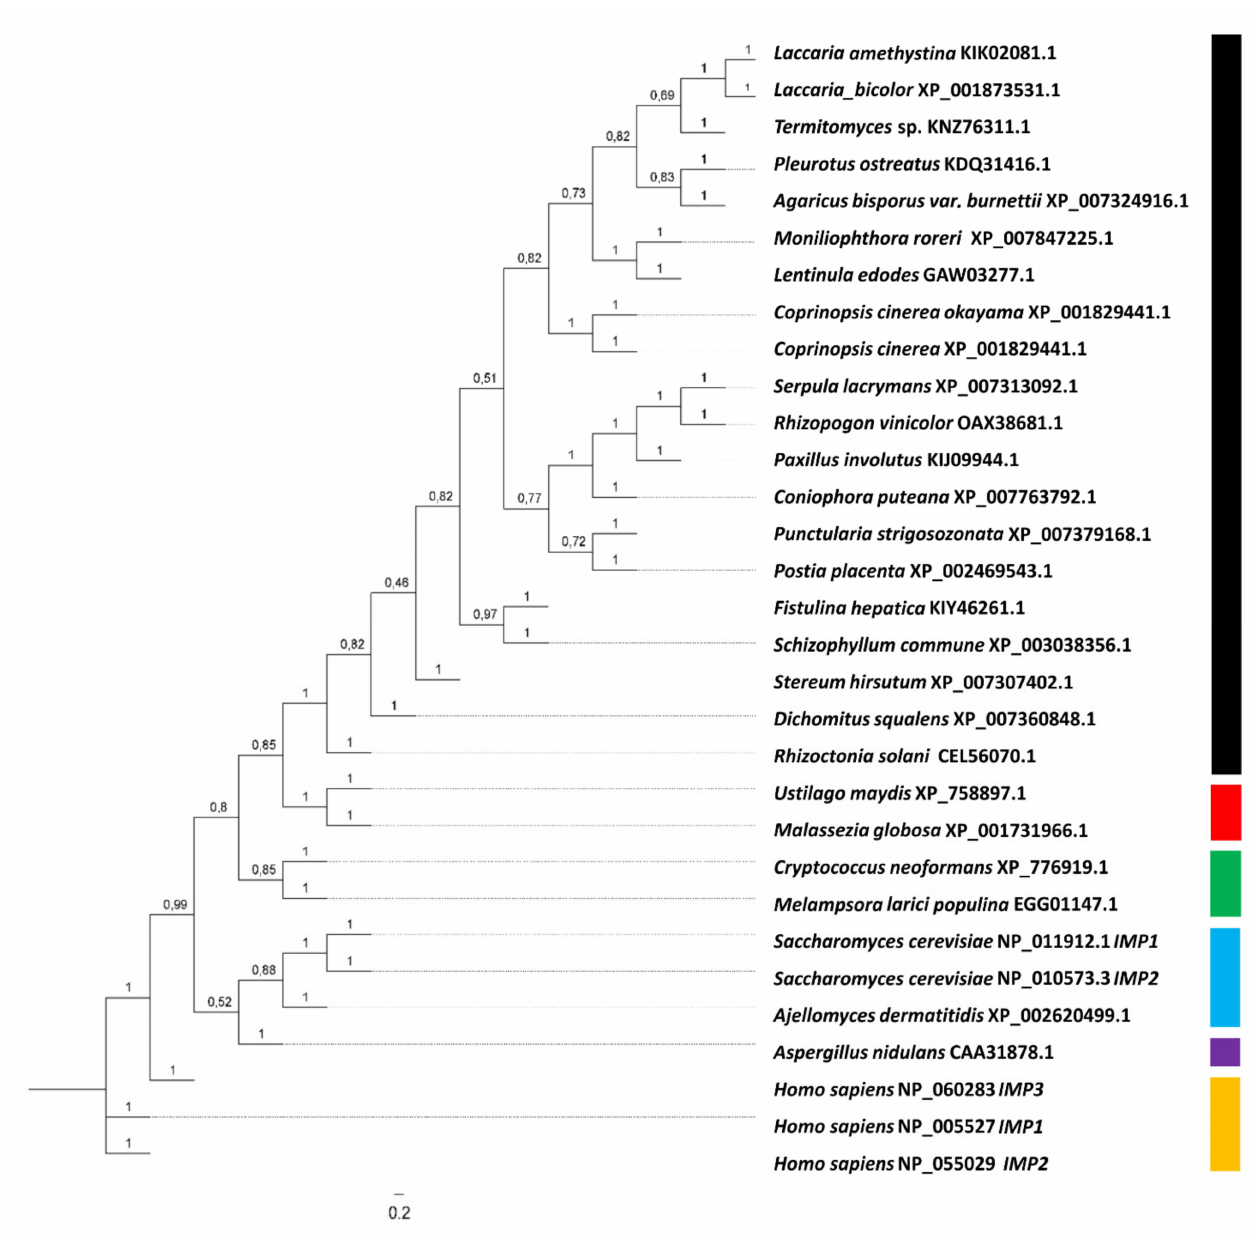
Figure 2. Phylogenetic tree for IMPases. Accession numbers (GeneBank) are given for all sequences. IMPase clades are indicated with filamentous Basidiomycota (black), yeast-like Basidiomycota I (red), yeast-like Basidiomycota II (green), yeast-like Ascomycota (blue), filamentous Ascomycota (purple) und human IMPases